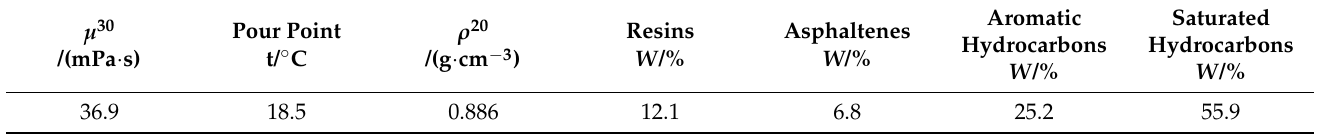
Table 1. The physical parameters of oil from Yanchang oil